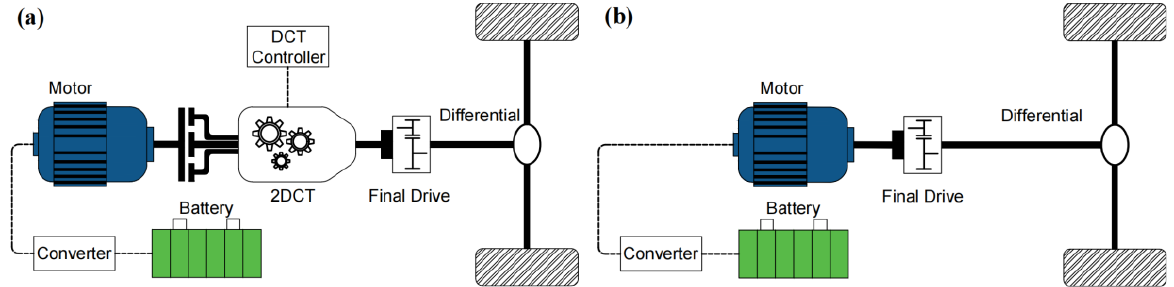
Figure 1. Configurations of EVT and EV: ( a ) EVT; ( b ) EV. Table 1. The parameters of EVT and EV.